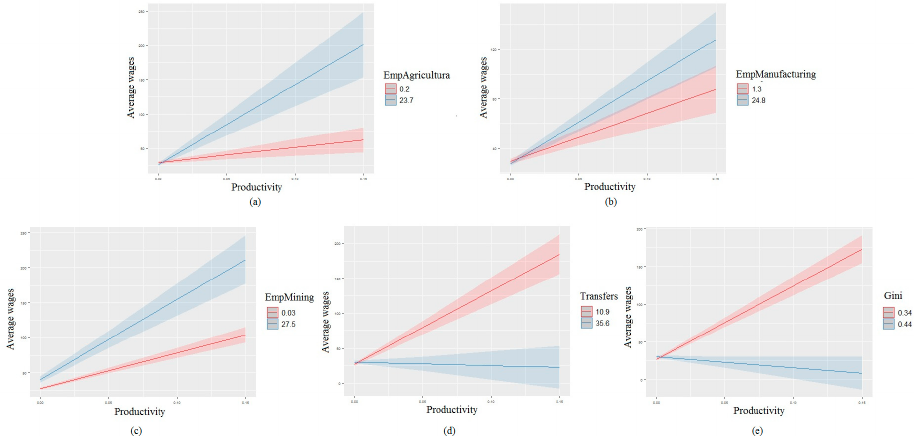
Figure A3. Marginal effects of interaction terms from model 4i where average wages are the de- pendent variable, production per capita are the independent variable at the municipal level со следующими grouping factor at the regional level: ( a ) the share of employees in the agriculture and fisheries; ( b ) the share of employees in the manufacturing industry; ( c ) the share of employees in the mining industry ж ( d ) the volume of patents granted for inventions and utility models per 10,000 population; ( e ) the Gini coefficient of population income. Minimum and maximum values (lower and upper bounds) of the moderator are used to plot the interaction.